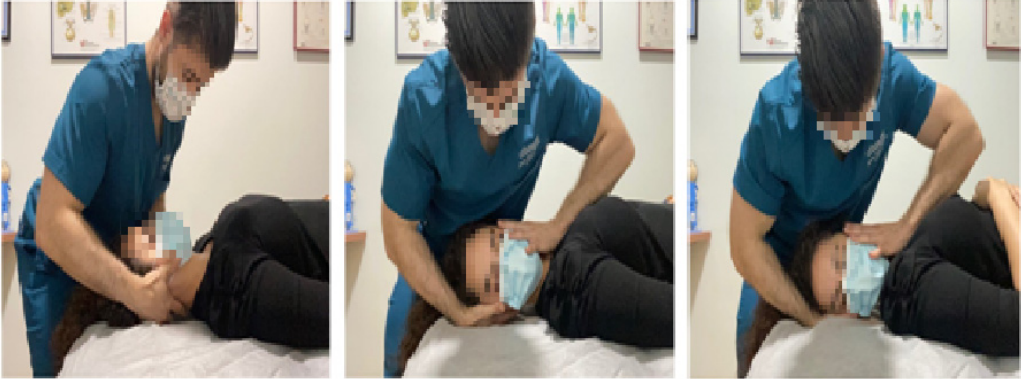
Figure 3. Upper cervical manipulation technique.